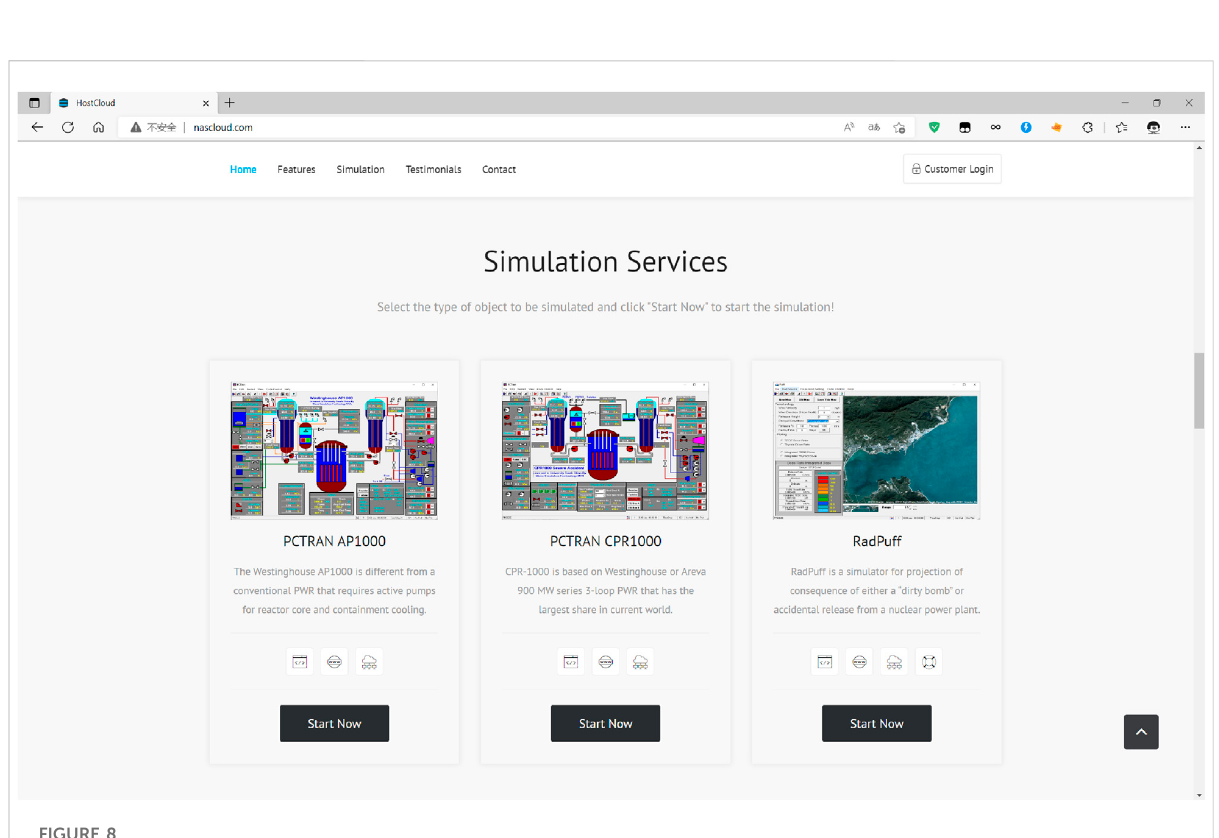
Entrance of resource service